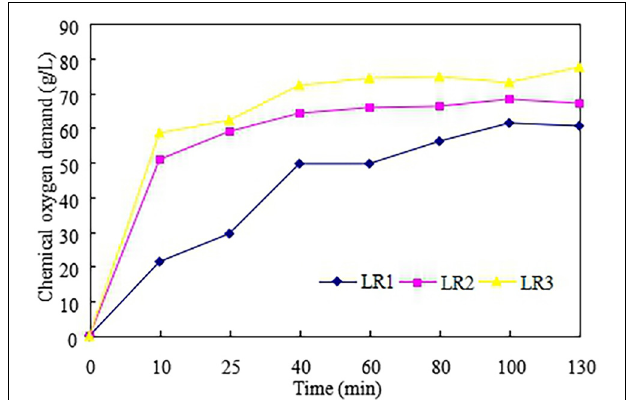
FIGURE 2 | Production of the chemical oxygen demand in the enzymatic hydrolysis of leftover cooked rice.